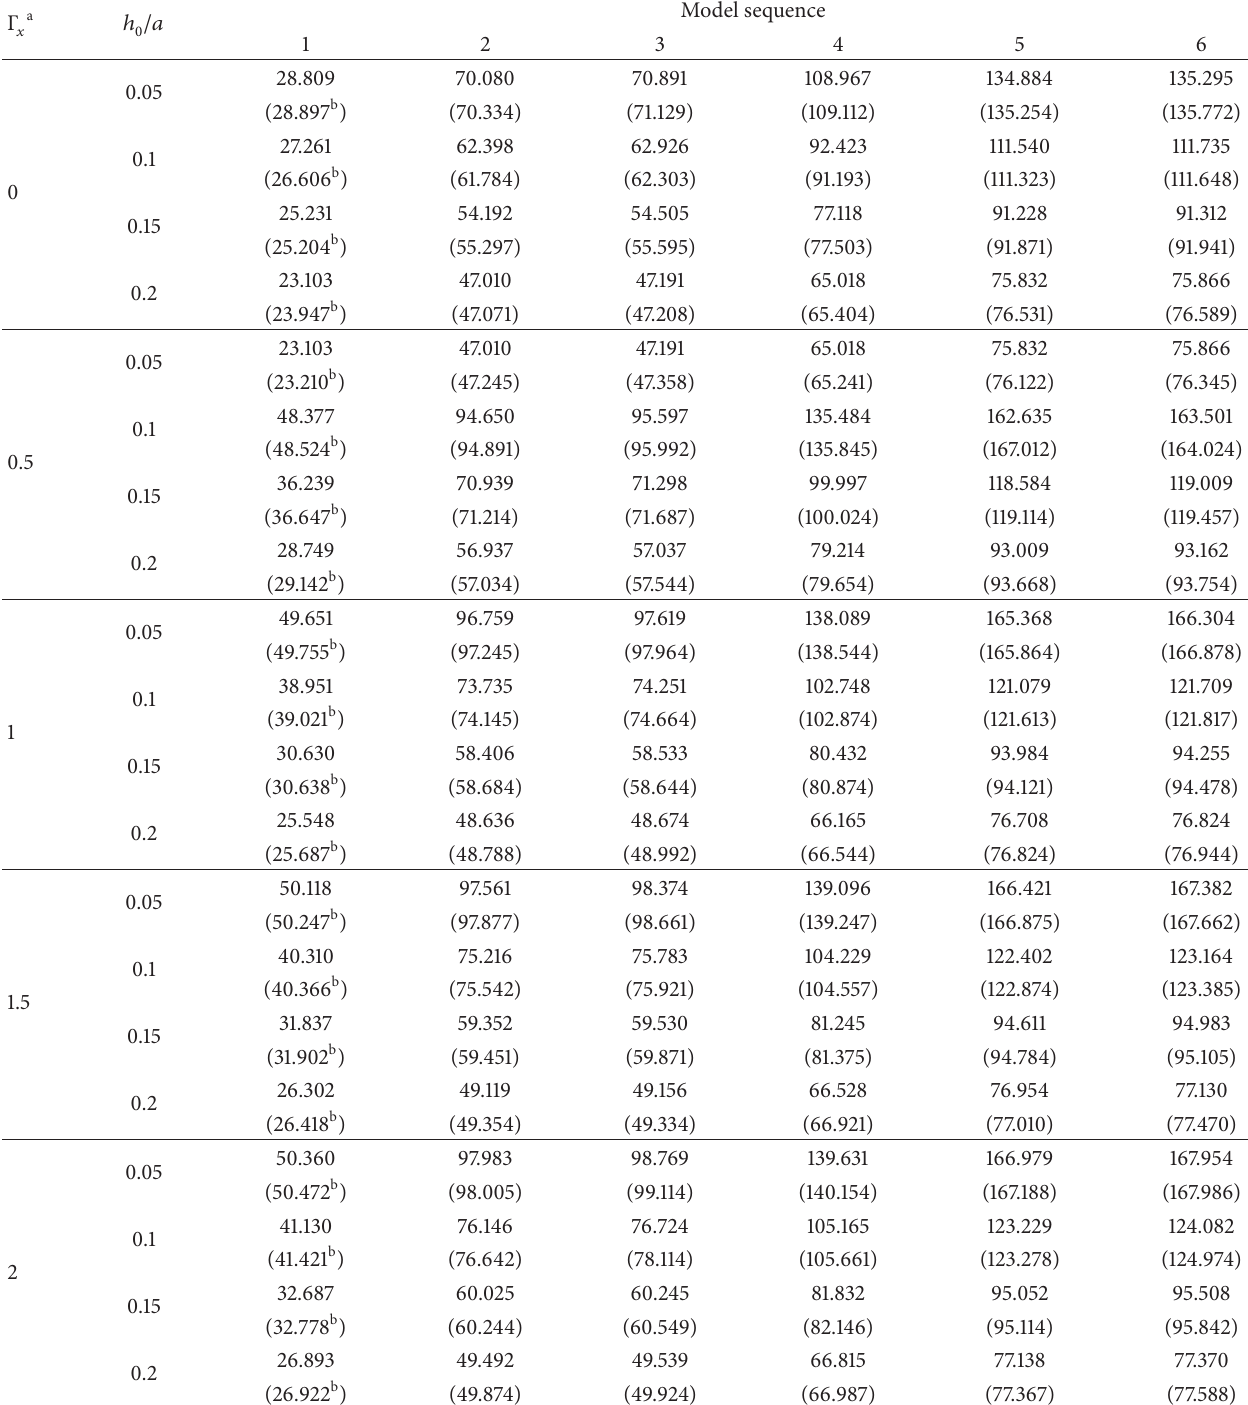
Table 6: Frequency parameter Ω = 𝜔𝑎 2 (𝜌ℎ 0 /𝐷 0 ) 1/2 for S-S-S-S moderately thick plates ( 𝑎/𝑏 = 1 ) with linearly varying thickness and